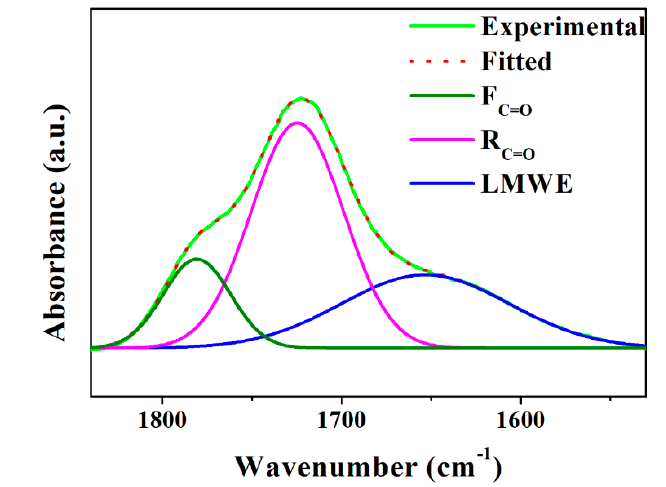
Figure 6. FTIR spectra of ( a ) PBAT, ( b ) PBAT/m-PPZn-01, ( c ) PBAT/m-PPZn-05, and ( d ) PBAT/m-PPZn-10 before and after 21 days UV irradiation.